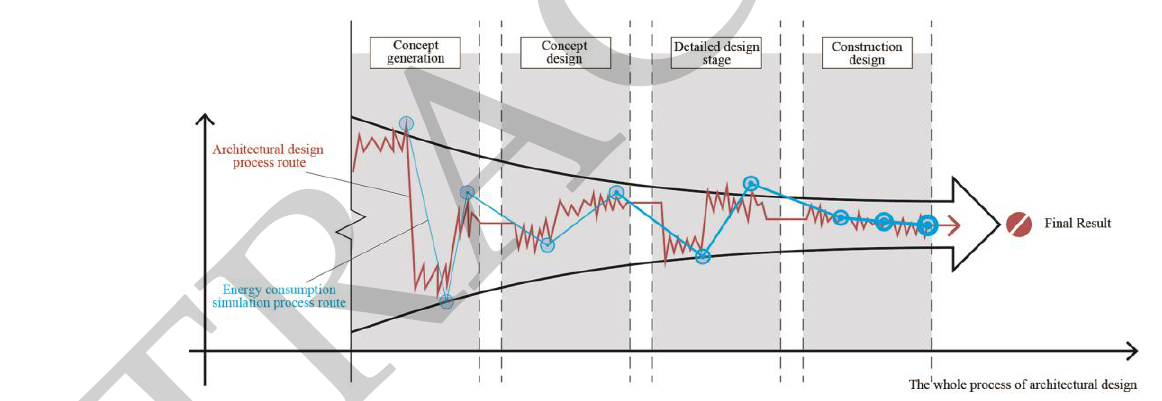
Figure 2. The synergetic relationship between energy simulation and architectural design.